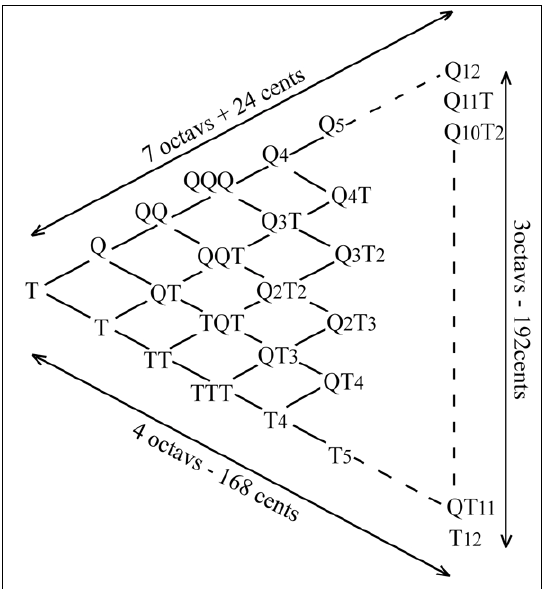
FIGURE 5. An equational representation of the truncated tree of overtones, including information about the deviations from the simple 12-tone system. The pattern is converted from a millimeter